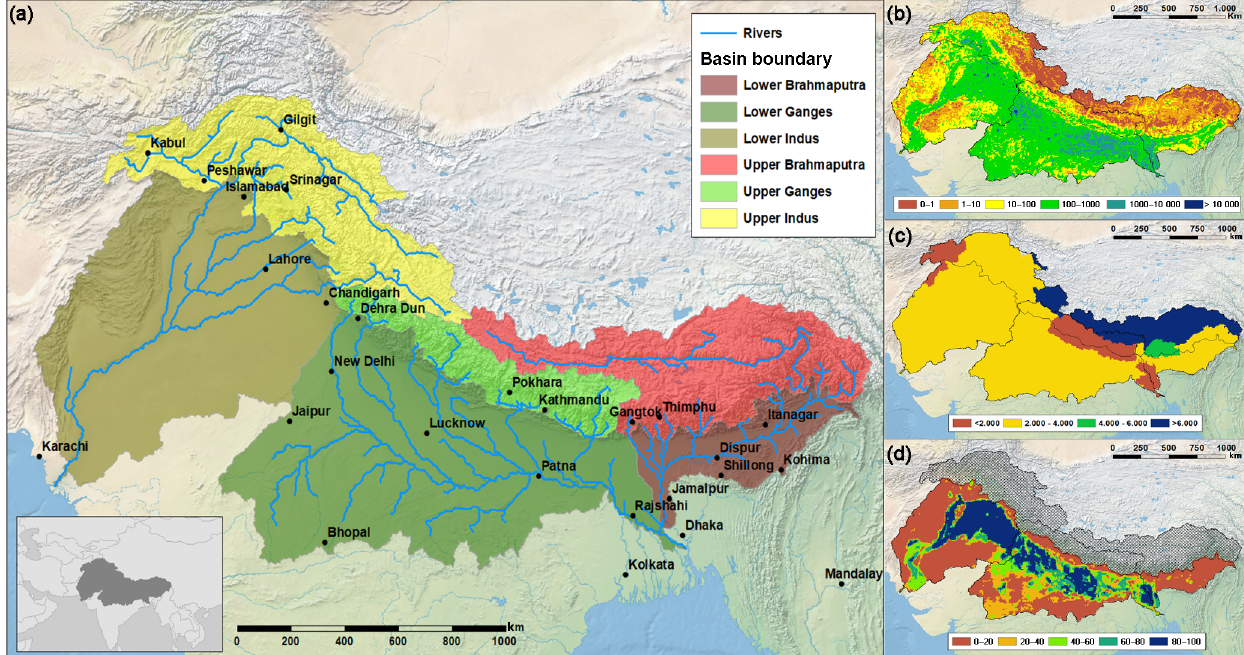
Figure 1. (a) Map of study area showing the sub-basins and the largest cities in the region, (b) the population density (inhabitantskm − 2 ), (c) the GDP (PPP) per capita per country (USDinhabitant − 1 ), and (d) the fraction of irrigated cropland (%). The source of the background imagery, the cities, and the political borders illustrated in the inlet is http://naturalearthdata.com/ (last access: 6 December 2017). The source of the population density data is the HYDE v3.2 database (Klein Goldewijk et al., 2010). The GDP (PPP) per capita is derived from IIASA SSP database (IIASA, 2017). The fraction of the irrigated cropland is derived from the MIRCA2000 dataset (Biemans et al., 2016; Portmann et al.,